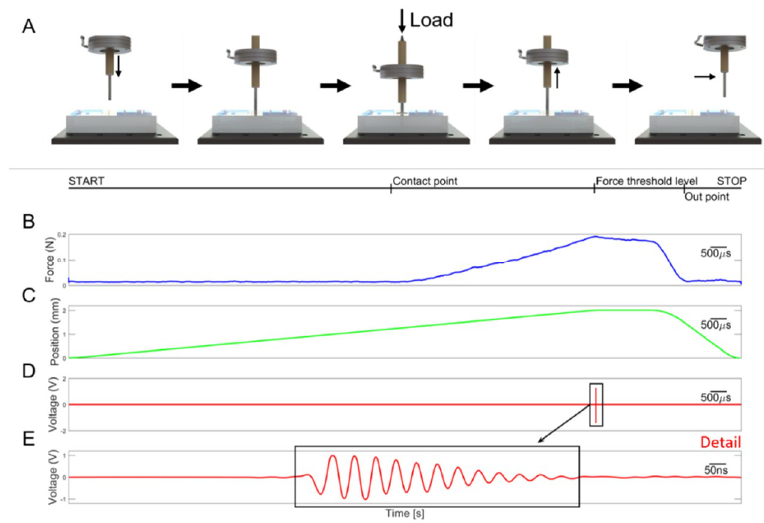
Figure 5. ( A ) Experimental protocol involving indentation of the ultrasound probe under regulation of the contact force. ( B ) Normal force. ( C ) Position along Z -axis. ( D ) Ultrasound signal reflected from the steel metal plate. ( E ) Zoom of the ultrasonic signal shown in panel D reflected at the tissue sample bottom in contact with the steel plate.